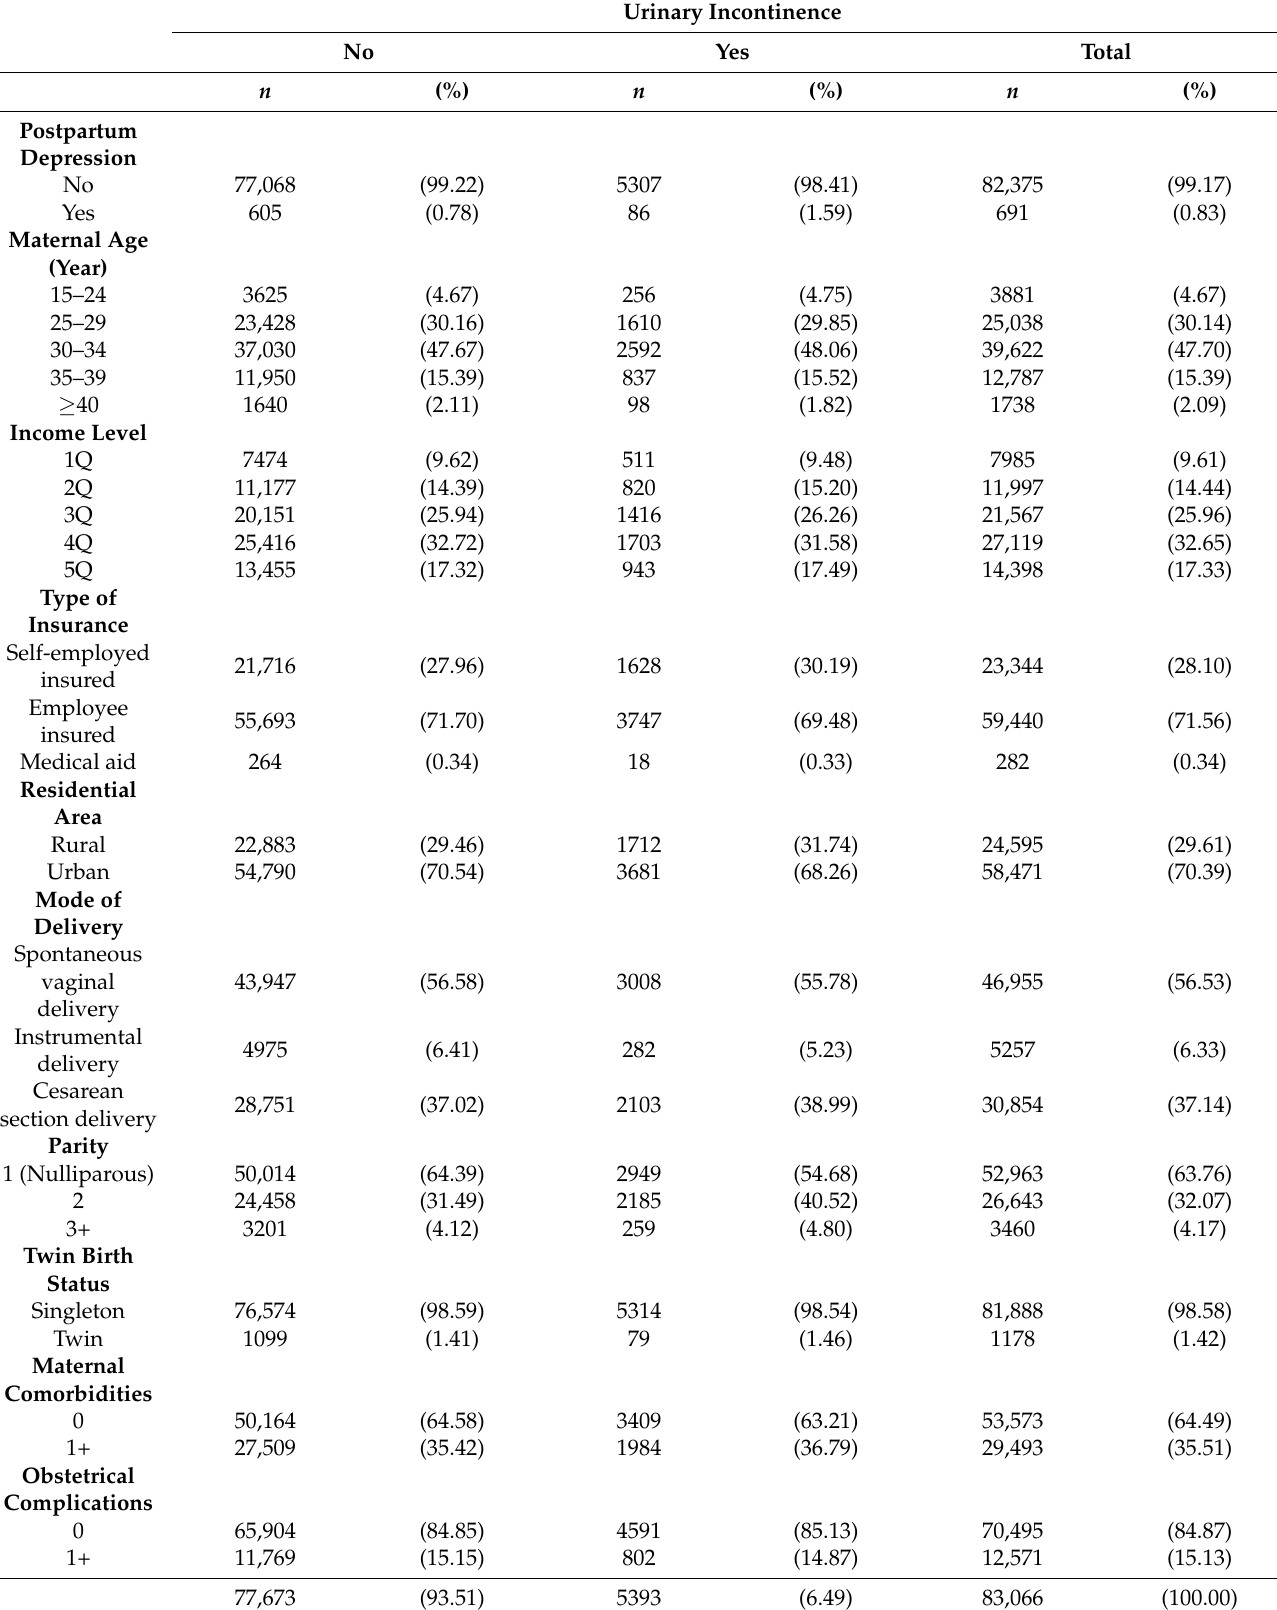
Table 1. General characteristics of the study